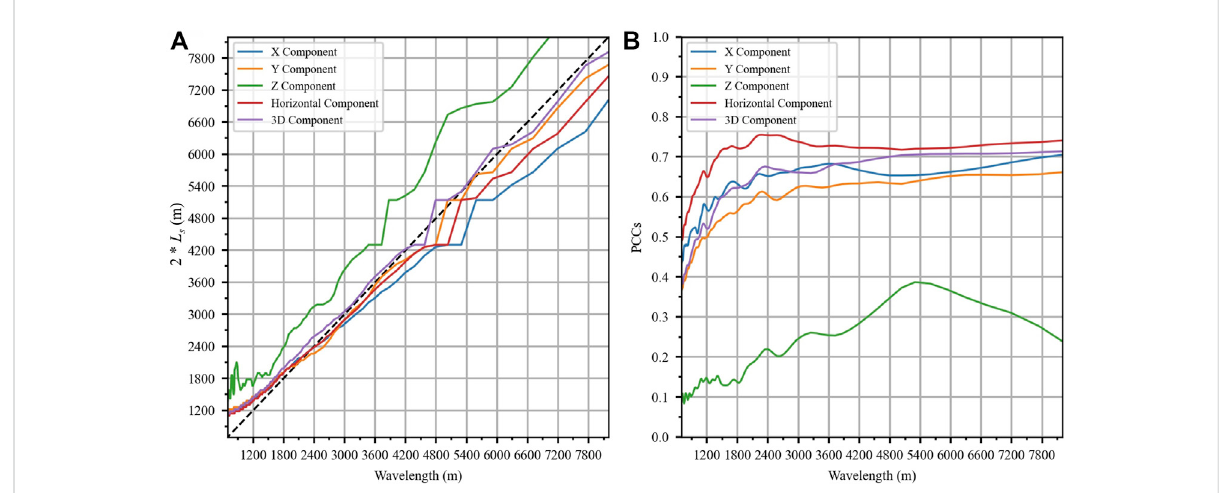
FIGURE 9 The relationship between AF ( f ) and C s ; (A) The relationship betweenwavelengthand L s when AF ( f ) and C s is best correlated; (B) The maximum PCCs over different seismic wavelengths. Solid lines of different colors in (A,B) correspond to different components (see legend in the upper left for details), and black dashed line in (A) indicates that the value of the abscissa is equal to the ordinate.